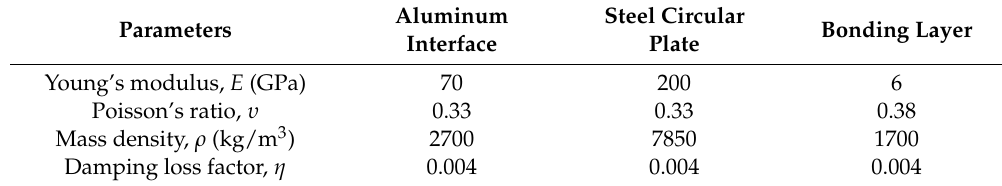
Table 1. Mechanical properties of interface, circular plate and bonding layer